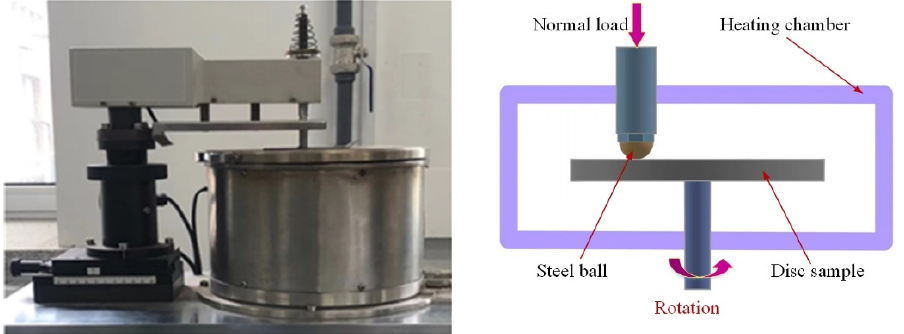
Figure 2. Tester and schematic diagram of ball-on-disc configuration.